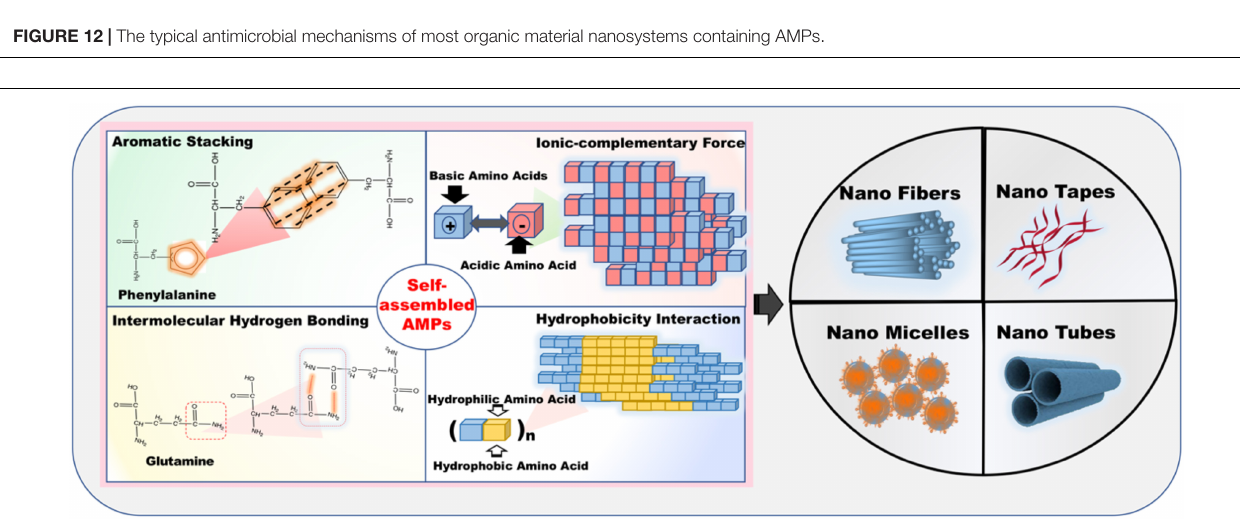
FIGURE 13 | The various acting forces (aromatic stacking, ionic-complementary force, intermolecular hydrogen bonding, and hydrophobicity interaction) of self-assembled AMPs and the self-assembled AMPs formed by these representative amino